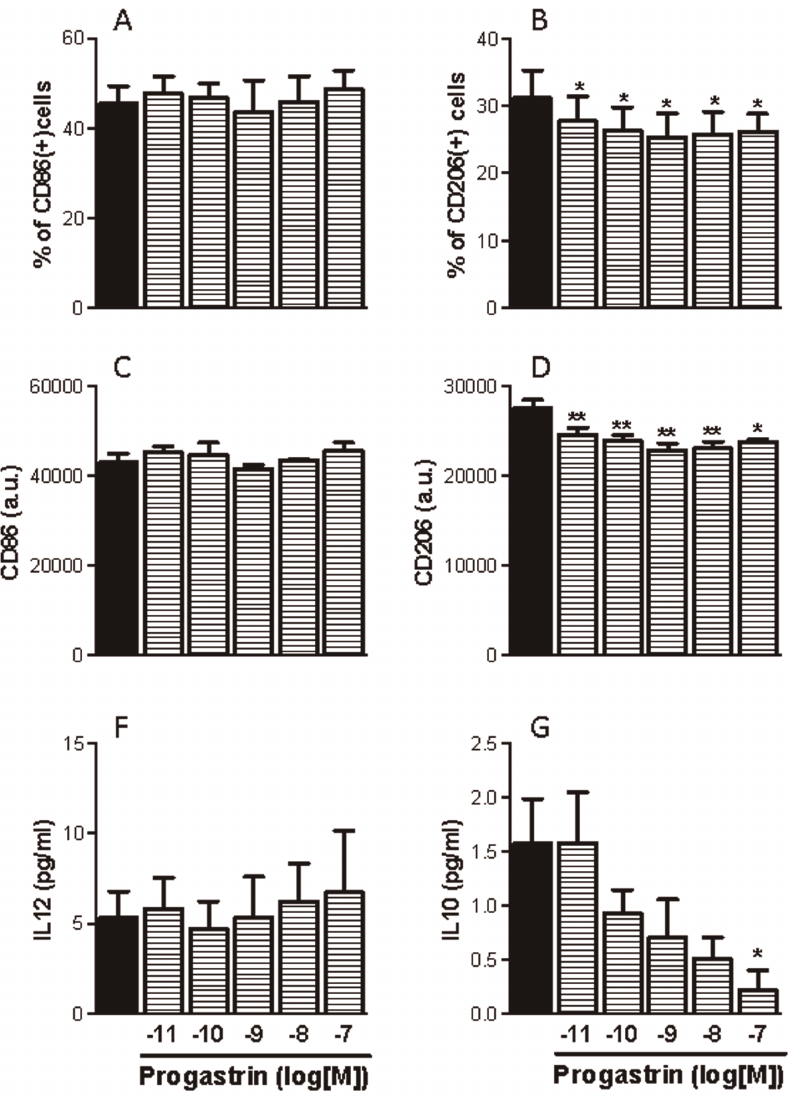
Figure 3. Influence of progastrin on the phenotype of human monocyte-derived macrophages. Human peripheral monocytes were derived to macrophages in the presence or absence of progastrin and the phenotype of the resultant macrophages evaluated by analyzing the following parameters: expression of CD86 (A, C, n=3); expression of CD206 (B, D, n=3); secretion of IL12 (F, n=4); and secretion of IL10 (G, n=4). Bars represent mean 6 SEM. *P , 0.05 and **P , 0.01 vs corresponding value in vehicle-treated cells.